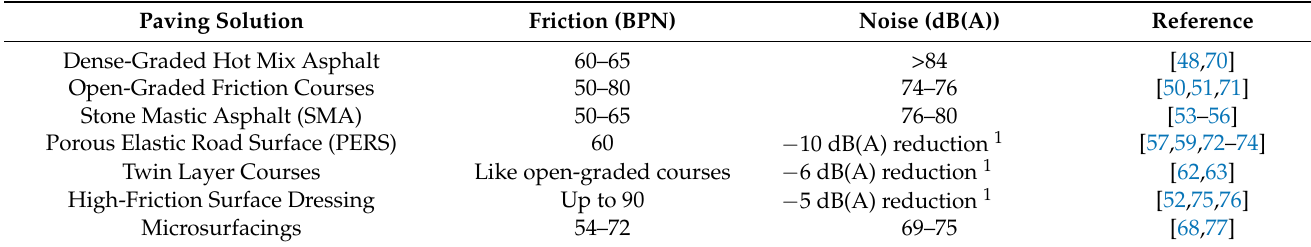
Table 1. Typical friction and noise characteristics of different paving